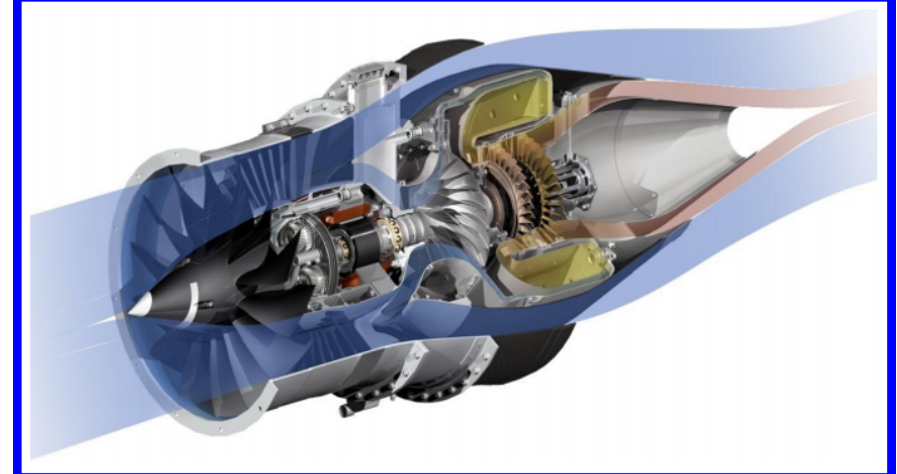
Figure 7. DGEN 380 geared turbofan.